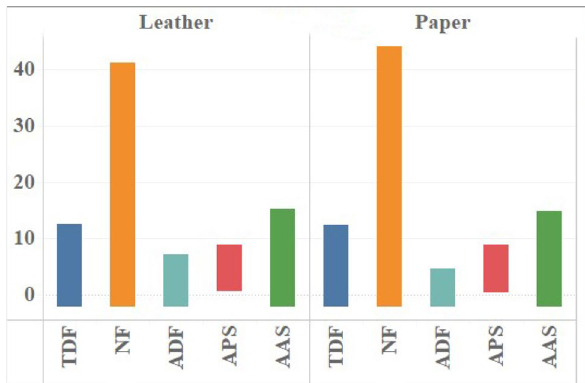
Figure 6. Eye movement index of different leaf texture.